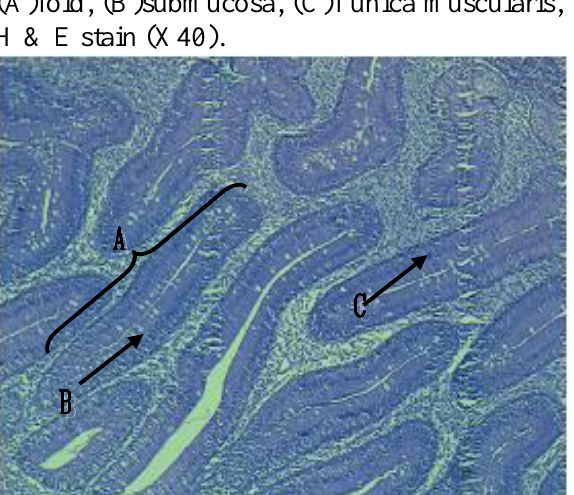
Figure, 9: Longitudinal microscopic section of anterior portion of intestine of common carp, (A) mucosal fold , (B) goblet cell (arrow),(C) Columnar cells, AB stain (X100).